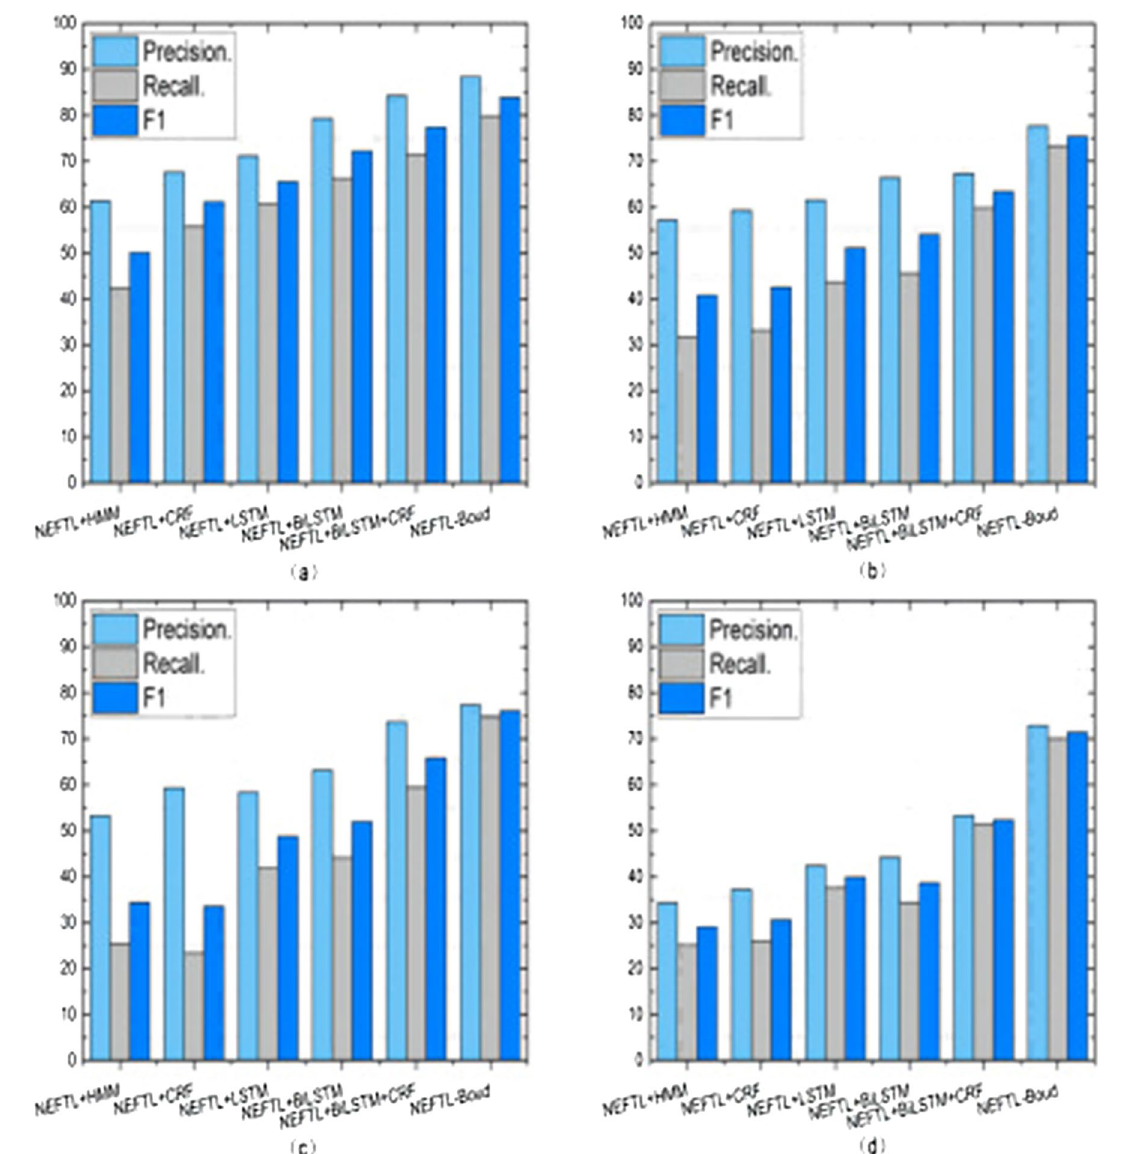
Fig. 6 Histogram of control experiment